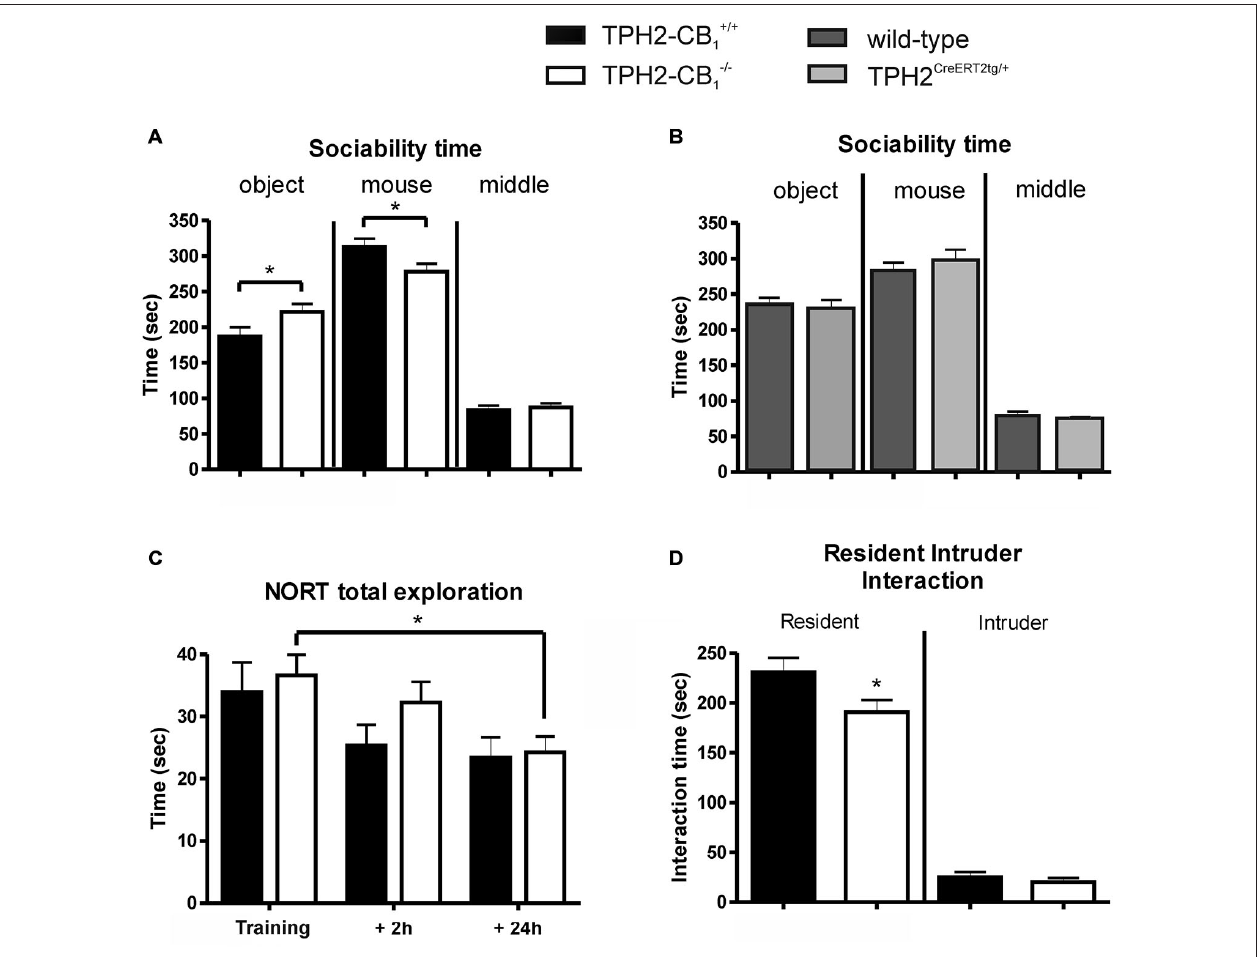
FIGURE 4 | Social and object exploration. (A) In the sociability test, social exploration was reduced in mutant animals, whereas object exploration was increased as compared with control littermates. (B) In contrast to TPH2-CB 1 − / − mice, mice only possessing the CreER T2 transgene (TPH2 CreERT 2 tg / + ) did not show any behavioral alterations in the sociability paradigm as compared to their wild-type littermates. (C) No genotype differences were observed in the novel object recognition test (NORT), as both groups spent an equal amount of time exploring the objects. (D) The resident intruder (RI) test revealed that the social interaction initiated by mutant mice was reduced compared to control littermates. This reduction did not depend on the behavior of the C57BL/6N intruder as intruders showed the same interaction time towards both groups of residents. n [Sociability] = 18 WT+ 21 KO; n [NORT] = 12 WT + 11 KO, n [RI] = 30 WT + 30 KO; n [CreERT2] = 14 WT + 15 KO; 2-Way ANOVA with Bonferroni’s post hoc test; ∗ p <